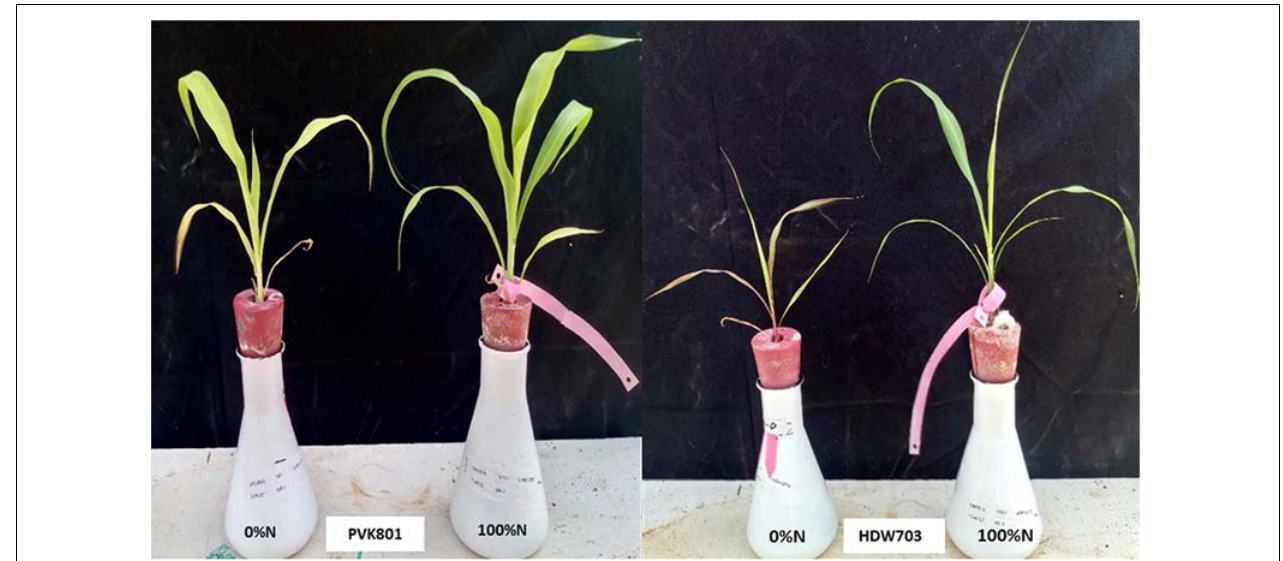
FIGURE 1 | High NUE/better (PVK801) and low NUE/poor (HDW703) performers grown under varying N (N0 and N100) conditions in hydroponics system using modified Hoagland solution.